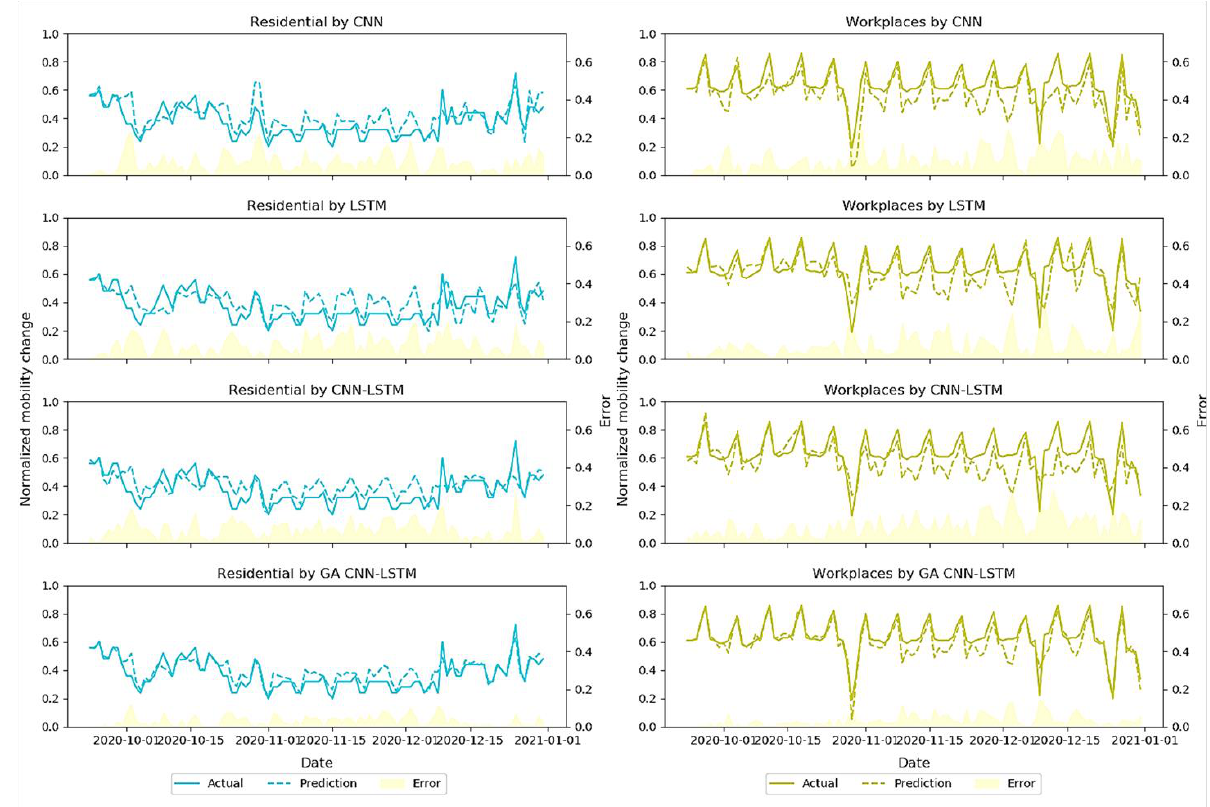
Figure 8. Plot of comparison between actual and prediction of mobility index for workplaces and residential area in Indonesia by CNN, LSTM, ensemble of CNN-LSTM and GA CNN-LSTM. Table 3. Comparison of RMSE for each mobility area produced by CNN, LSTM, ensemble of CNN-LSTM and GA CNN- LSTM when predicting mobility index in Indonesia. Mobility